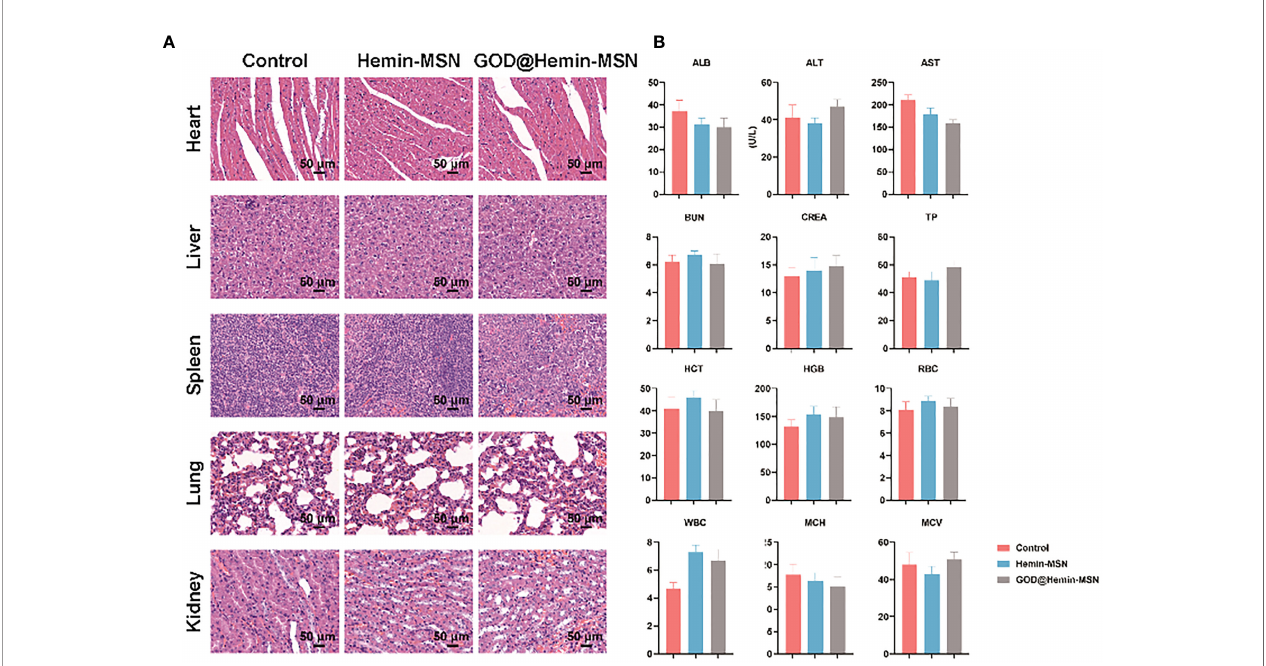
FIGURE 4 | (A) Light views of the main organs (heart, liver, spleen, lung, and kidney) with hematoxylin – eosin (H&E) staining. (B) Detection of the blood biochemical indicators. ALB, Albumin; ALT, Alanine aminotransferase; AST, Aspartate aminotransferase; BUN, Blood urea nitrogen; CREA, Creatinine; TP, Total protein; HCT, Hematocrit; HGB, Hemoglobin; RBC, Red blood cell; WBC, White blood cell; MCH, Mean corpuscular hemoglobin; MCV, Mean corpuscular